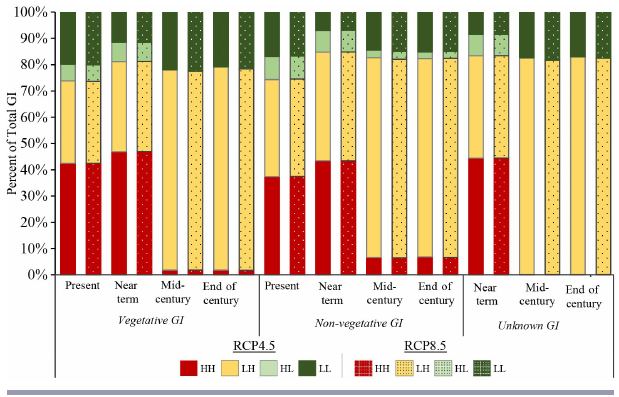
Fig. 6 . Comparison of predicted runoff (Q) and surface temperature (ST) regulating services at GI locations. High (H) measurements are above average and low (L) measurements are below average, respective of time period and climate change